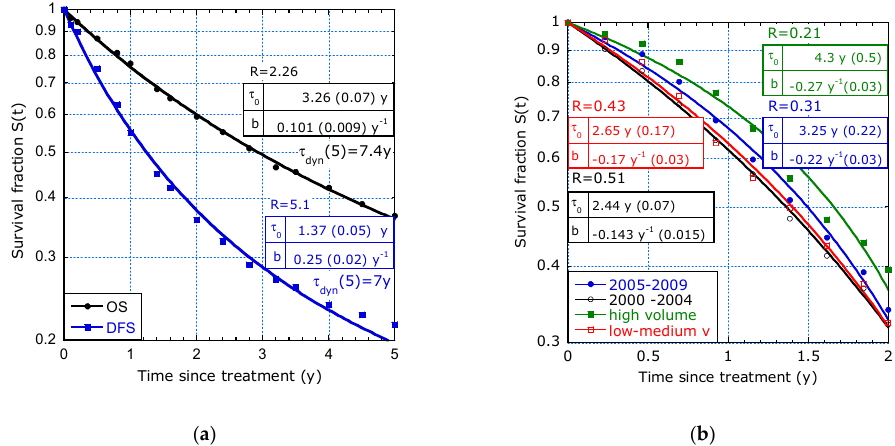
Figure 9. Filtering out of defects, b > 0 and accelerated aging, b < 0: ( a ) PC of digestive or primary origin with different tumour stages show for defect-free survival (DFS, squares) a ratio R ≈ 5.1 and for overall survival (OS) a ratio R ≈ 2.3 ([10], Figure 2); ( b ) Pancreatic cancer survival by period of and b.